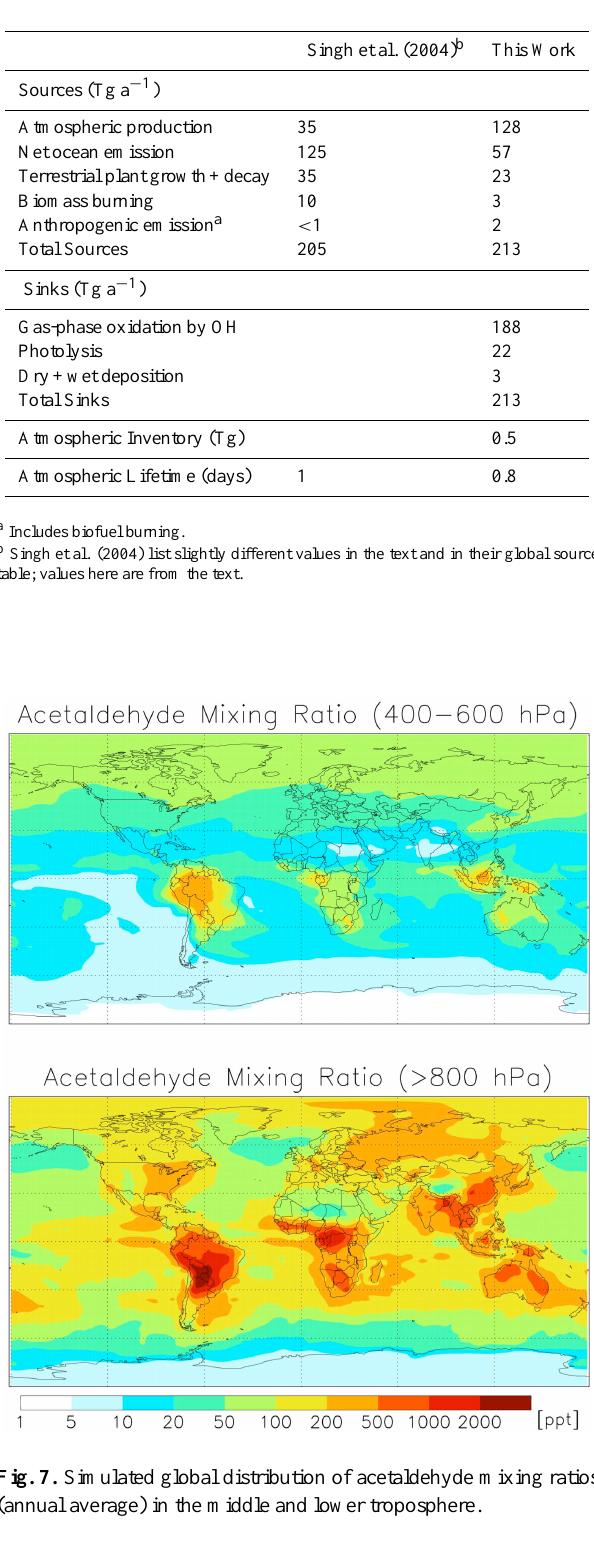
Table 2. Global Budget of Atmospheric Acetaldehyde.